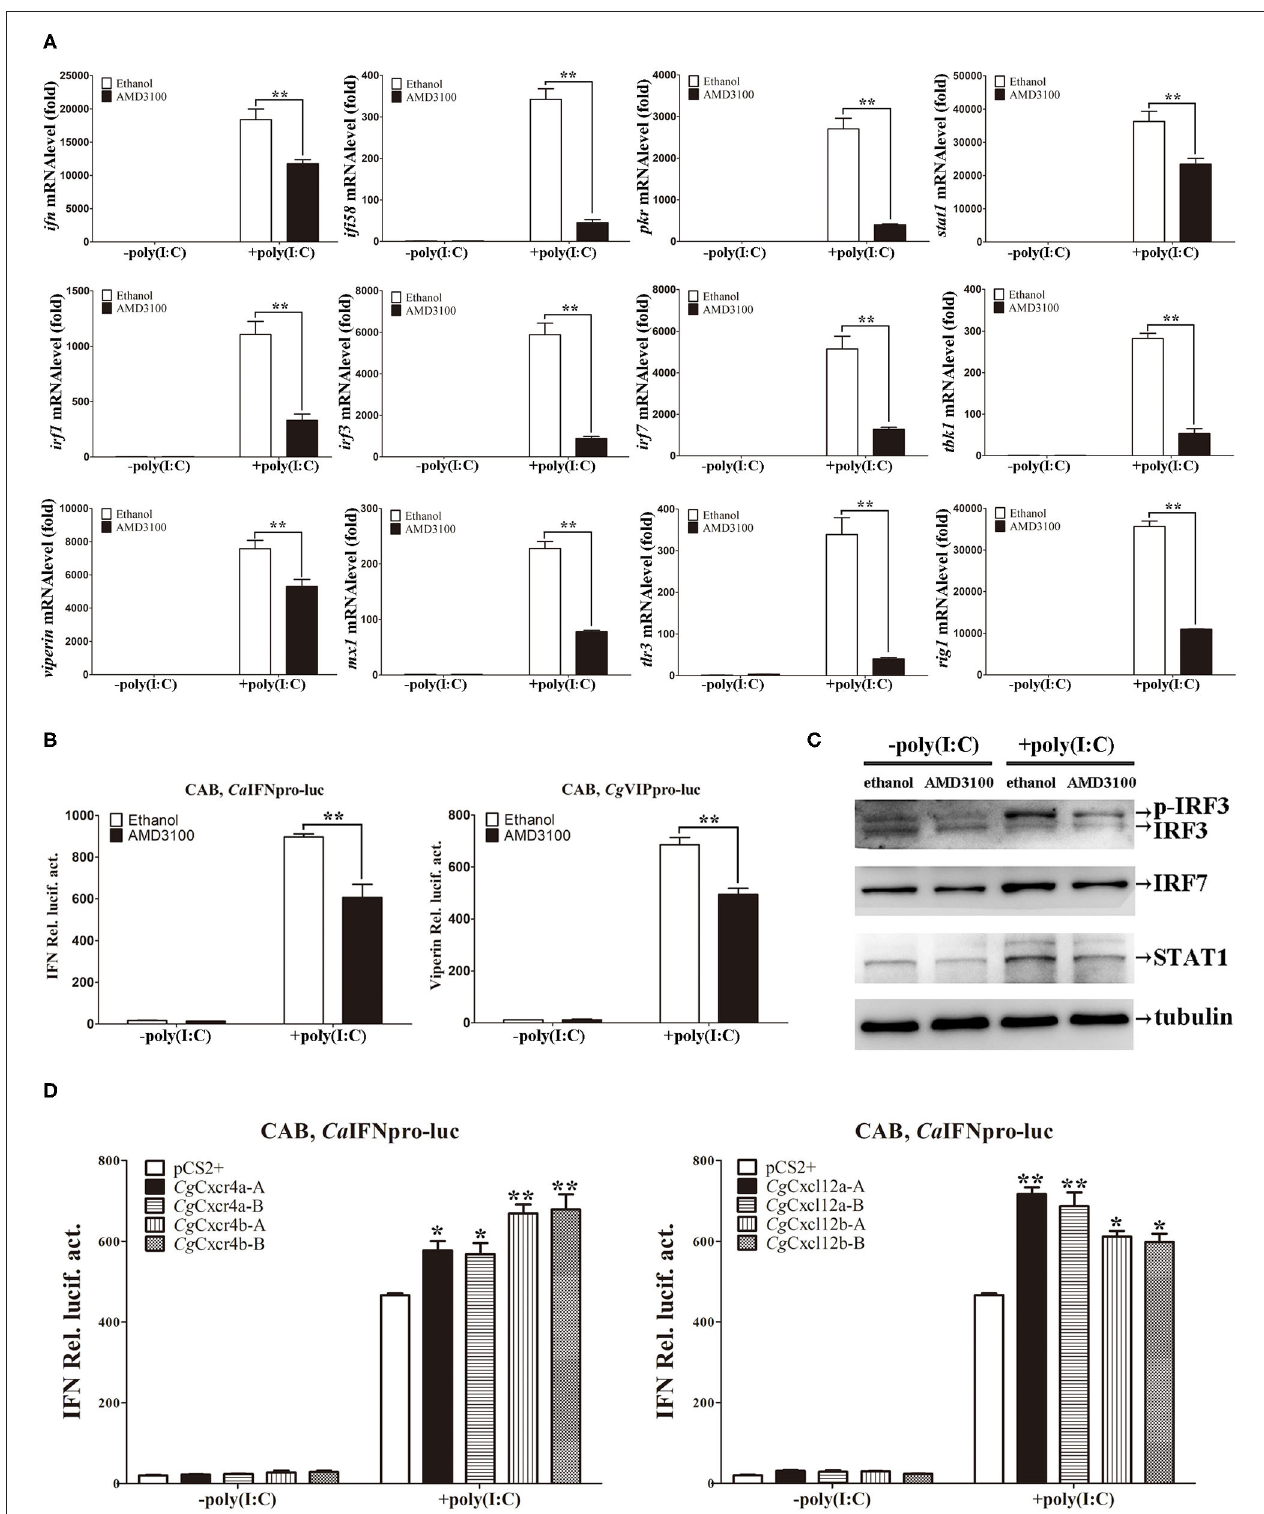
FIGURE 6 | Cg Cxcl12s and Cg Cxcr4s facilitated cellular antiviral response. (A) Treatment of CAB cells with 1 µ M AMD3100 after poly(I:C) stimulation suppressed the up-regulation expression of ifn , ifi58 , pkr , stat1 , irf1 , irf3 , irf7 , tbk1 , viperin , mx1 , tlr3, and rig1 . (B) AMD3100 inhibited the activation of fish IFN and viperin promoters